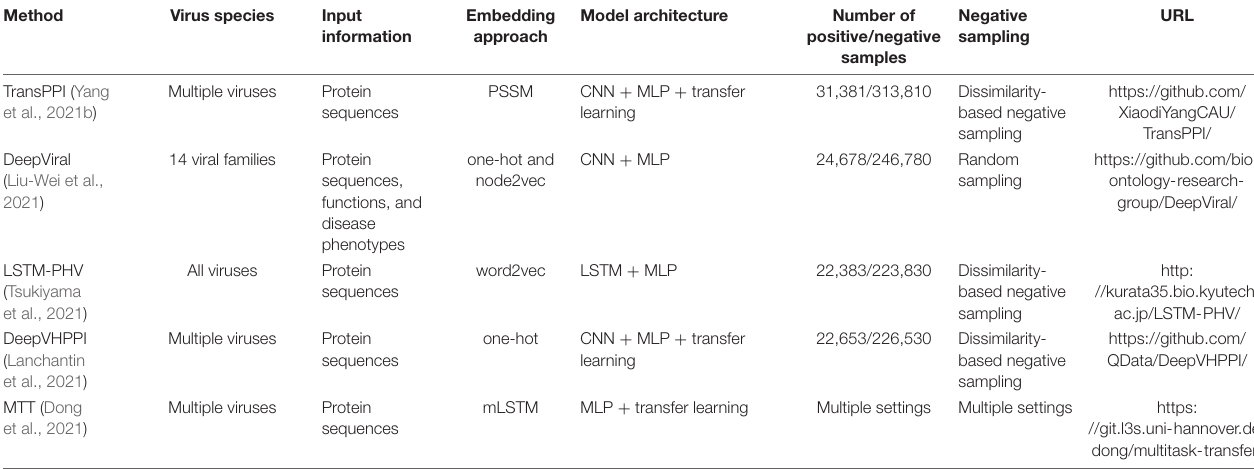
TABLE 1 | Existing deep learning prediction methods of human-virus